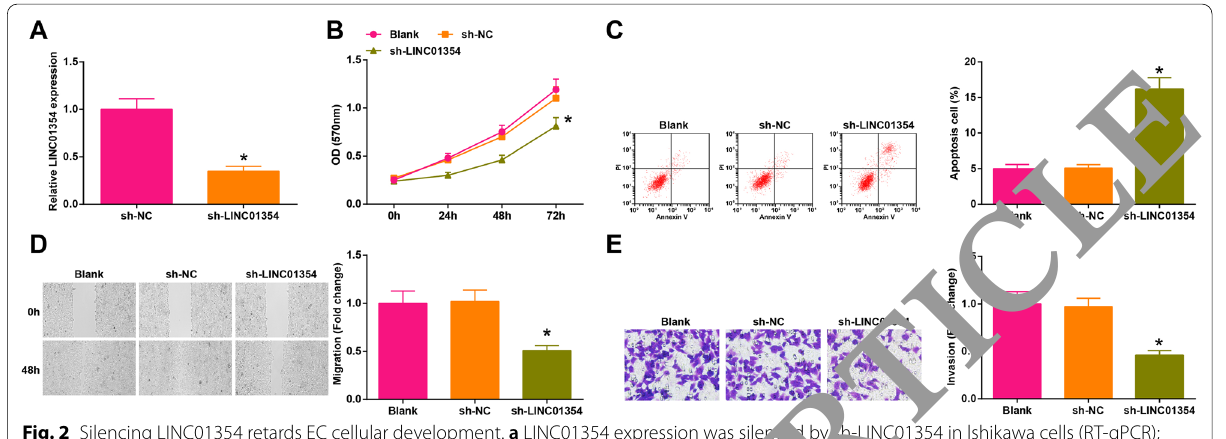
Fig. 2 Silencing LINC01354 retards EC cellular development. a LINC01354 expression was silenced by sh-LINC01354 in lshikawa cells (RT-qPCR); b Cell viability was suppressed by sh-LINC01354 transfection (MTT assay); c Cell apoptosis rate was enhanced by sh-LINC01354 transfection (flow cytometry); d Cell migration was inhibited by sh-LINC01354 transfection (scratch test); e Cell invasion was depressed by sh-LINC01354 transfection (Transwell assay). The data were expressed as mean